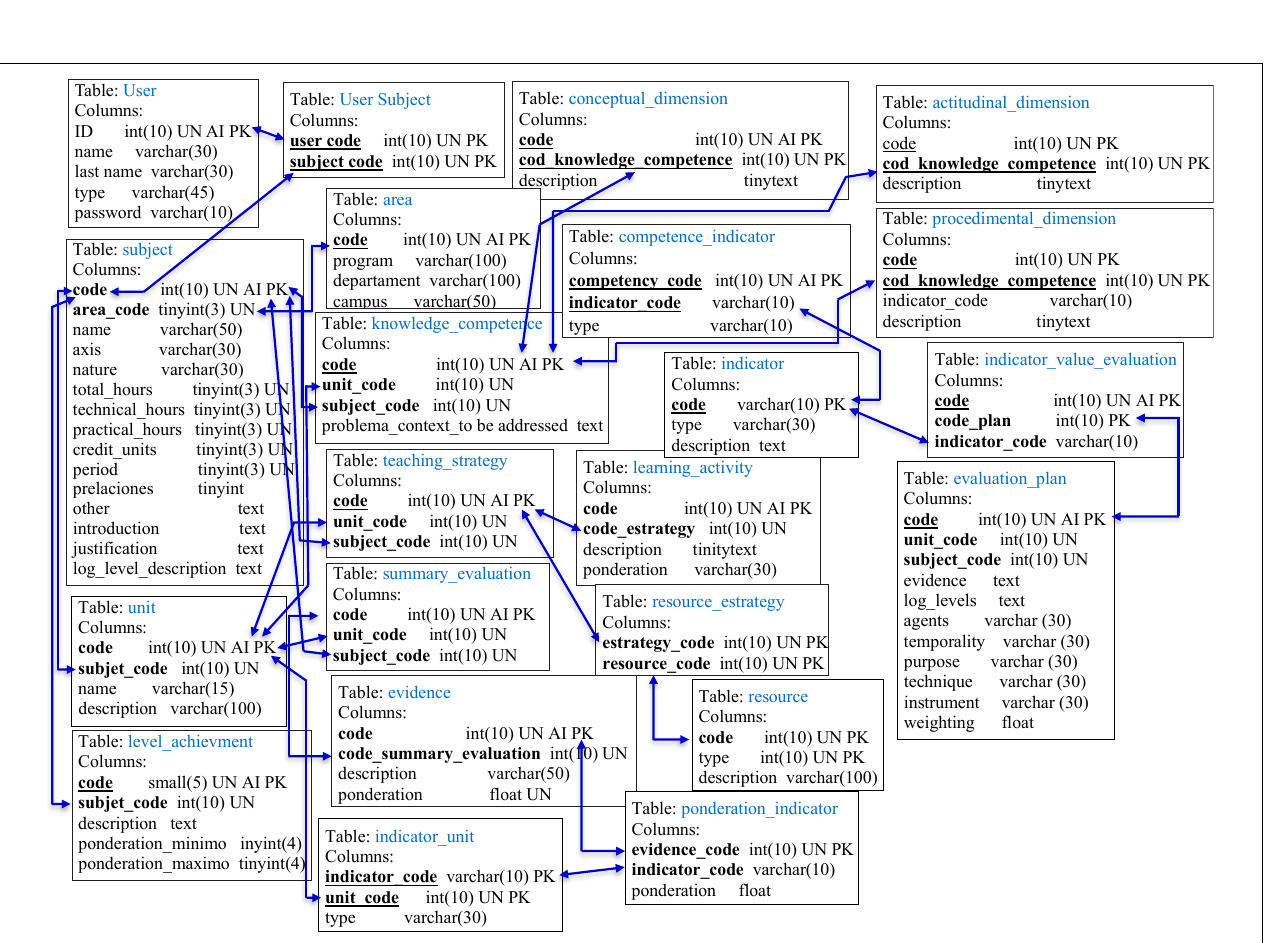
FIGURE 8 | Structured system chart.